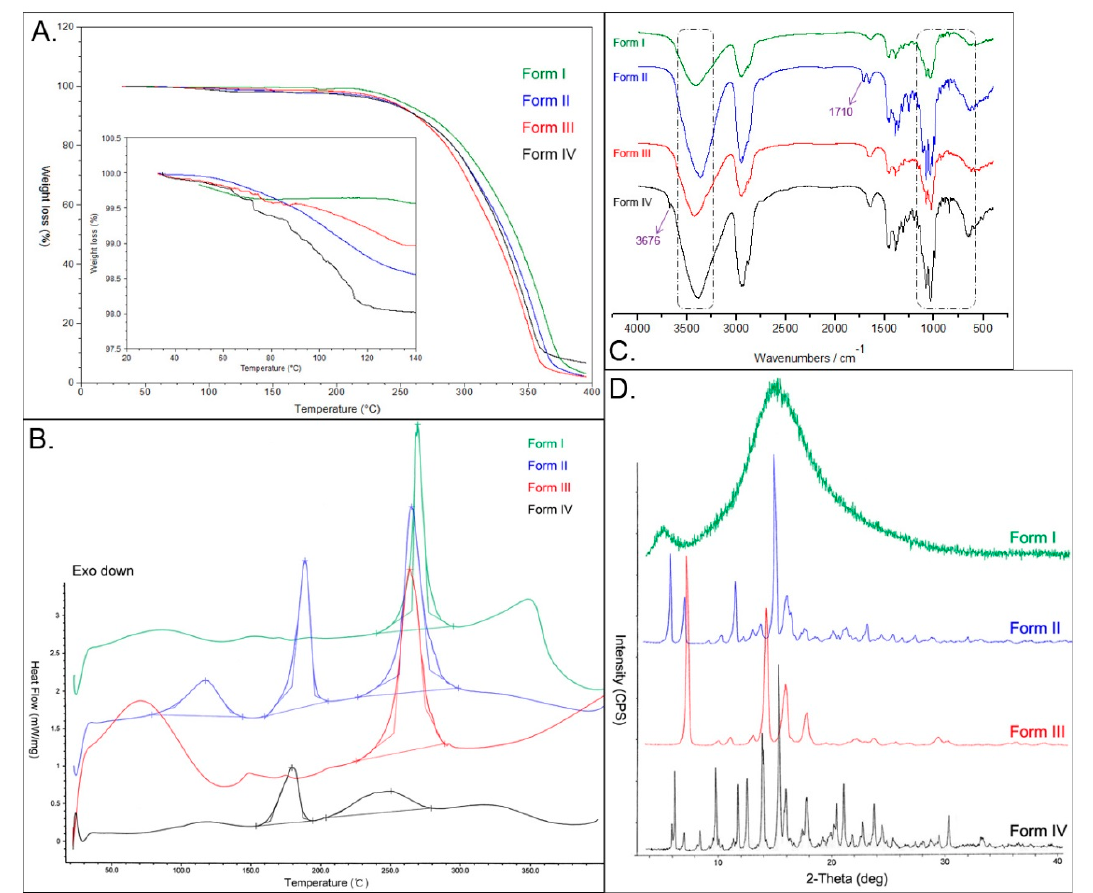
Figure 2. TGA ( A ) and differential scanning calorimetry (DSC) ( B ) curves of the four forms of CK were measured at 20 K/min from 20 to 400 °C under 50 mL/min dry nitrogen flow. DSC showed endothermic peaks of solvent desorption (below 140 °C), melting point (150–190 °C), and CK decomposition (250–270 °C). TGA showed a pronounced weight loss of